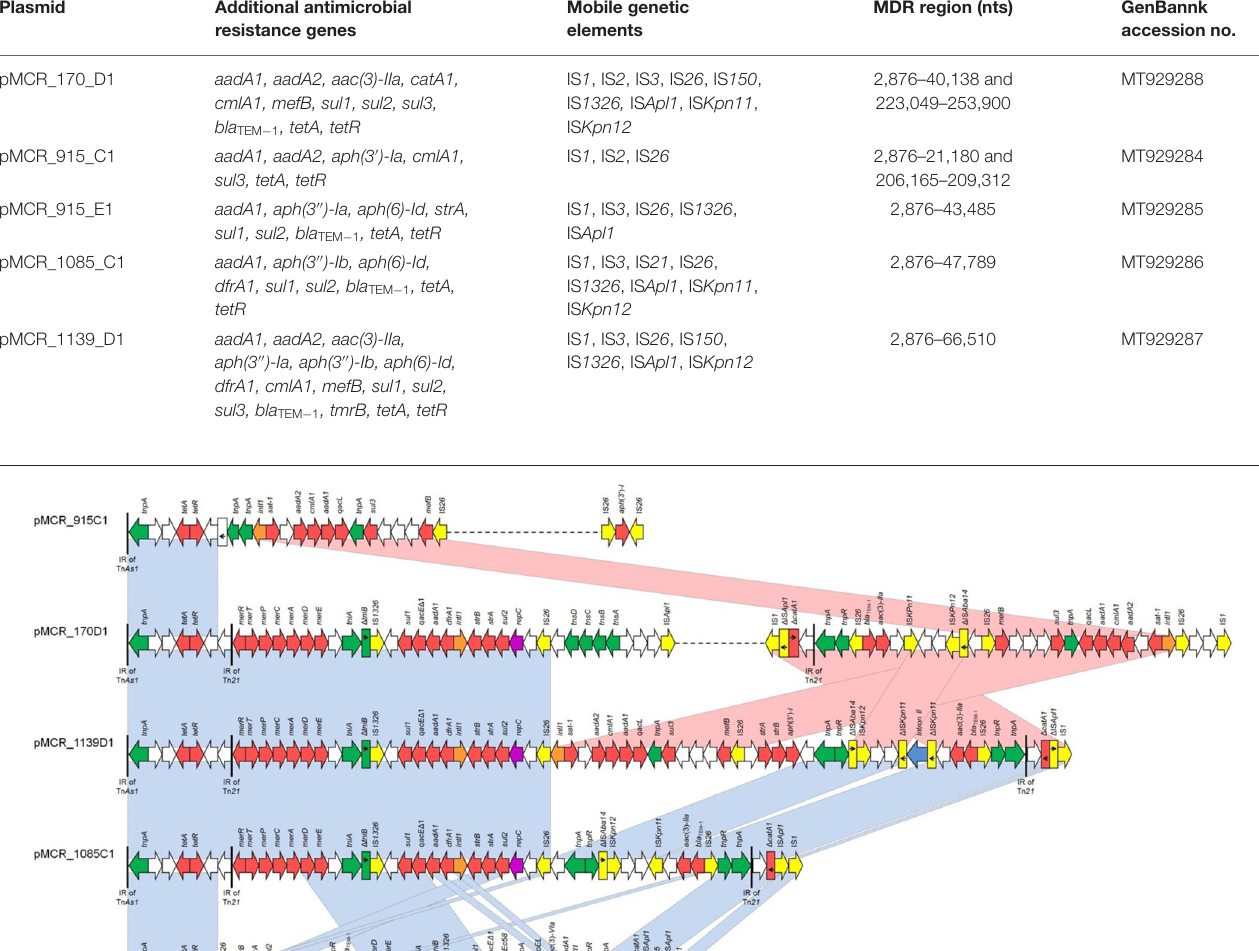
TABLE 2 | The additional antimicrobial resistance genes and mobile genetic elements in IncHI2 plasmids. Plasmid Additional antimicrobial resistance genes